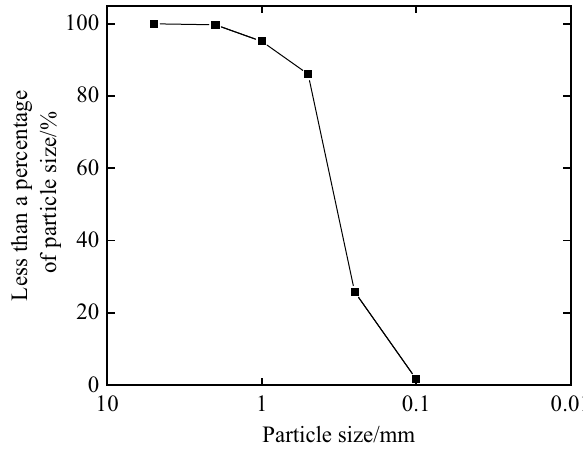
Figure 2: Particle gradation curve of test fi ller sand soil.